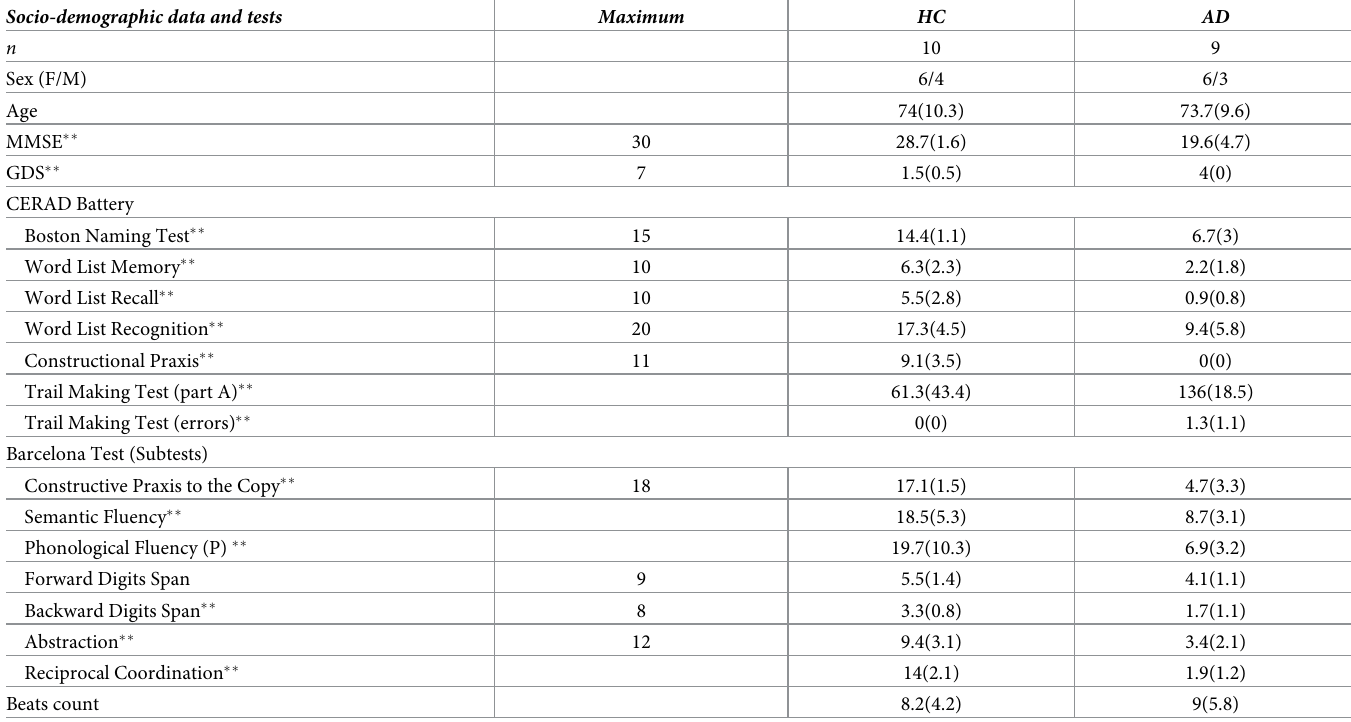
Table 1. Demographics and clinical information for the HC and AD groups. Mean scores and standard deviations (in parentheses) are